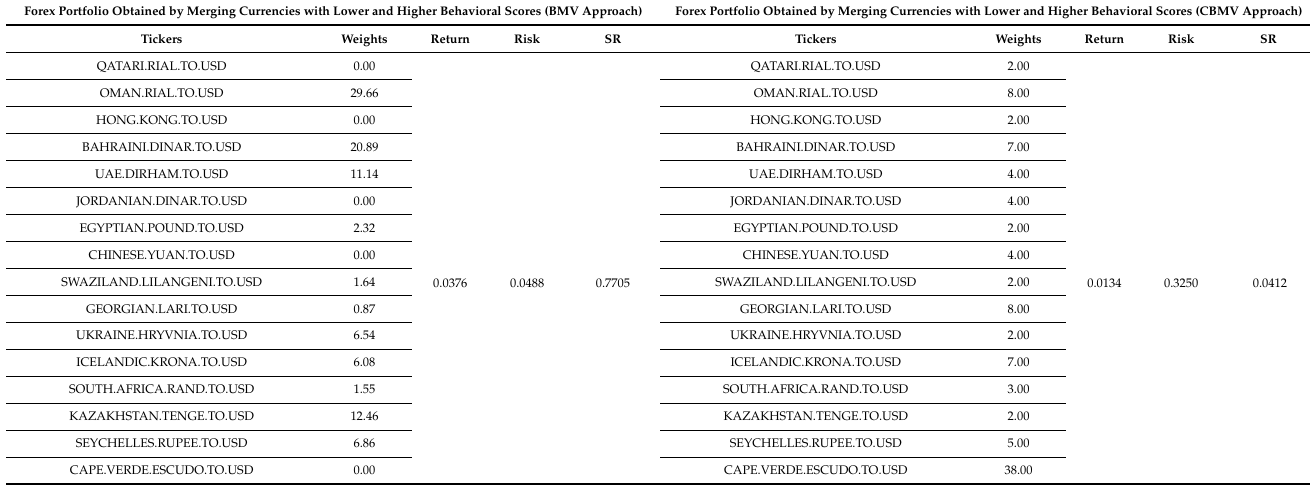
Table 10. Optimization results of Forex portfolios using BMV and CBMV,